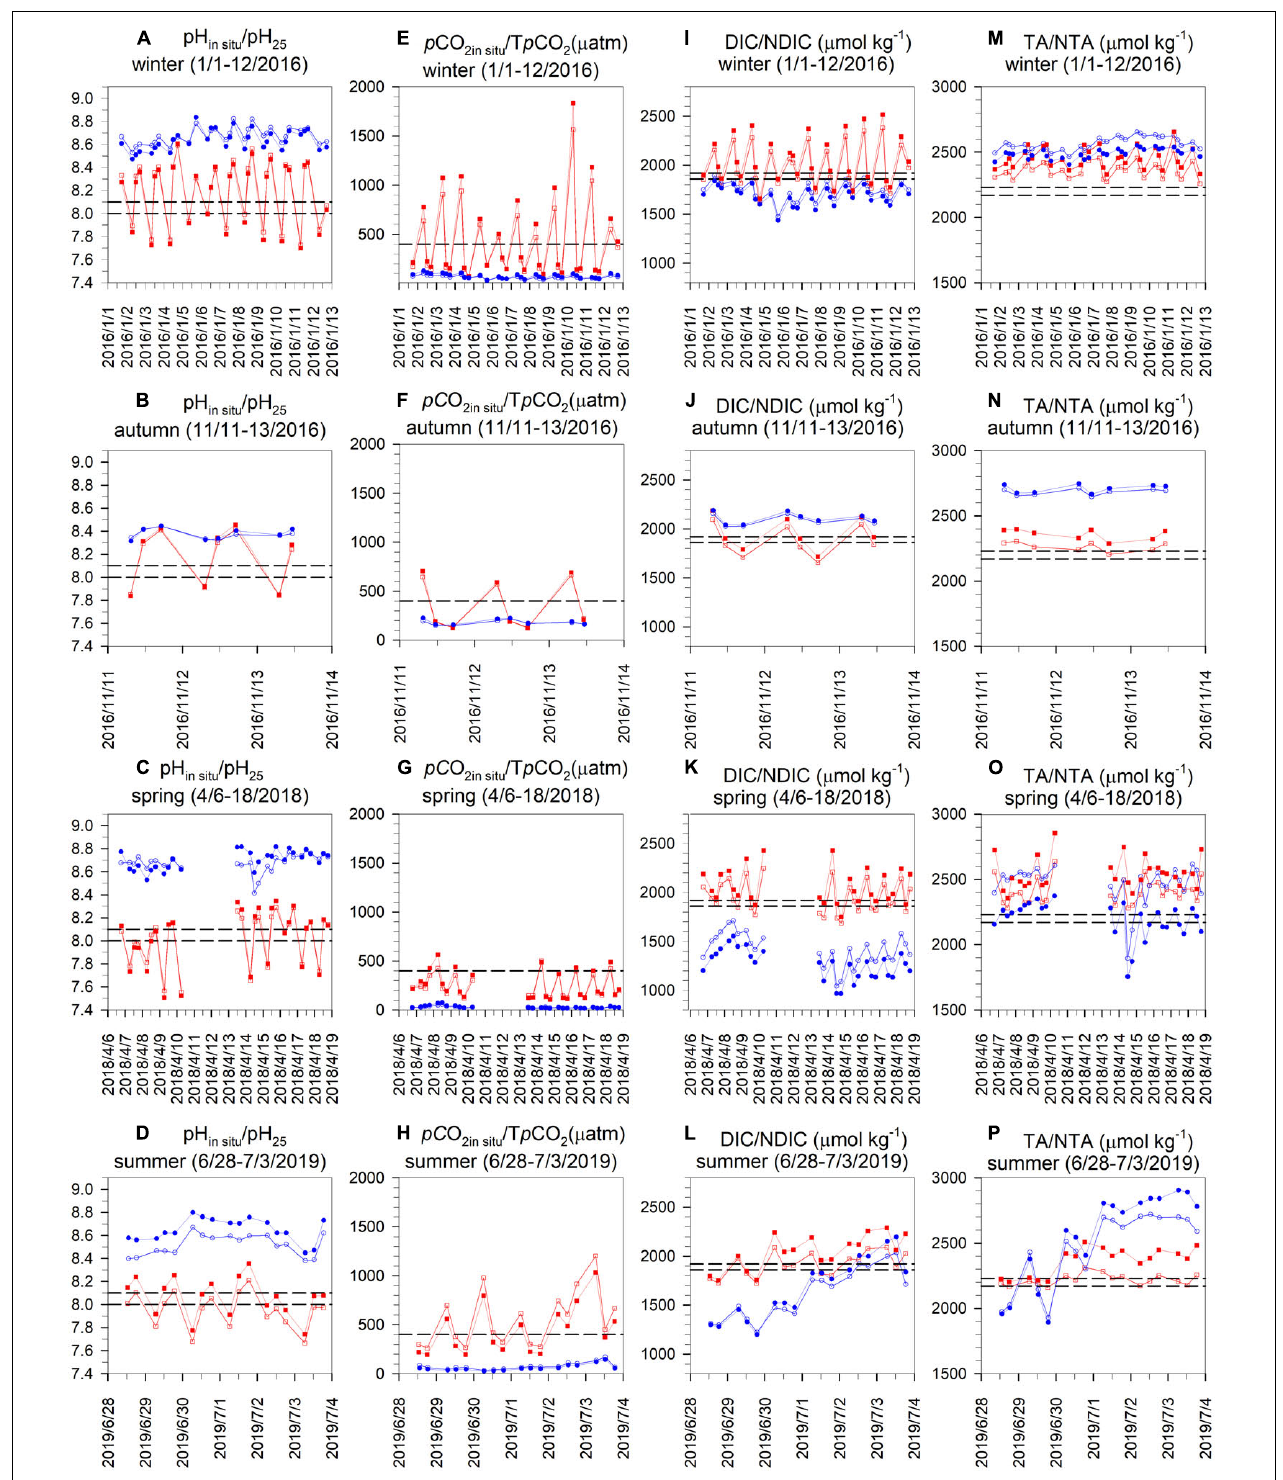
FIGURE 3 | Seasonal daily variations in (A–D) pH at in situ temperature (pH in situ , open symbols) and pH at 25 ◦ C (pH 25 , solid symbols), (E–H) p CO 2 in situ ( p CO 2 in situ , open symbols) and temperature normalized p CO 2 (T p CO 2 , solid symbols), (I–L) DIC (open symbols) and salinity normalized DIC (NDIC, solid symbols), and (M–P) TA (open symbols) and salinity normalized TA (NTA, solid symbols) in the inner lagoon (IL, blue circles) and on the northern shore (NS, red squares) of Dongsha Island. The horizontal bands superimposed on Panels (A–D,I–L,M–P) represent the typical seasonal variation ranges in pH, DIC, and TA, respectively, in the open northern South China Sea. The horizontal dashed lines shown in panels (E–H) denote atmospheric p CO 2 (400 µ atm).